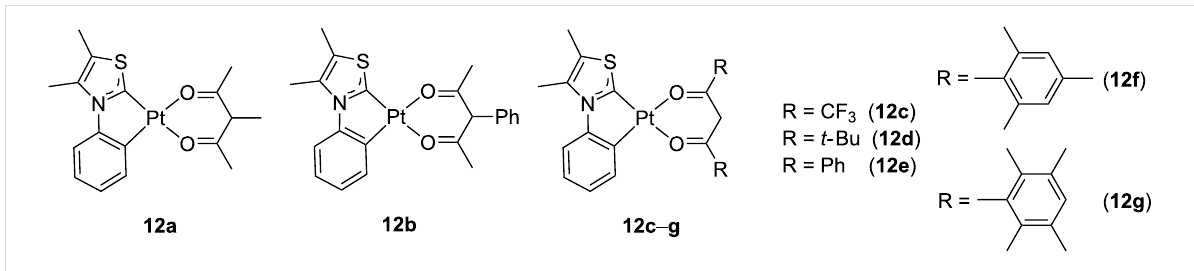
Figure 6: Cyclometalated thiazol-2-ylidene platinum(II) complexes with different acetylacetonate ligands [37].